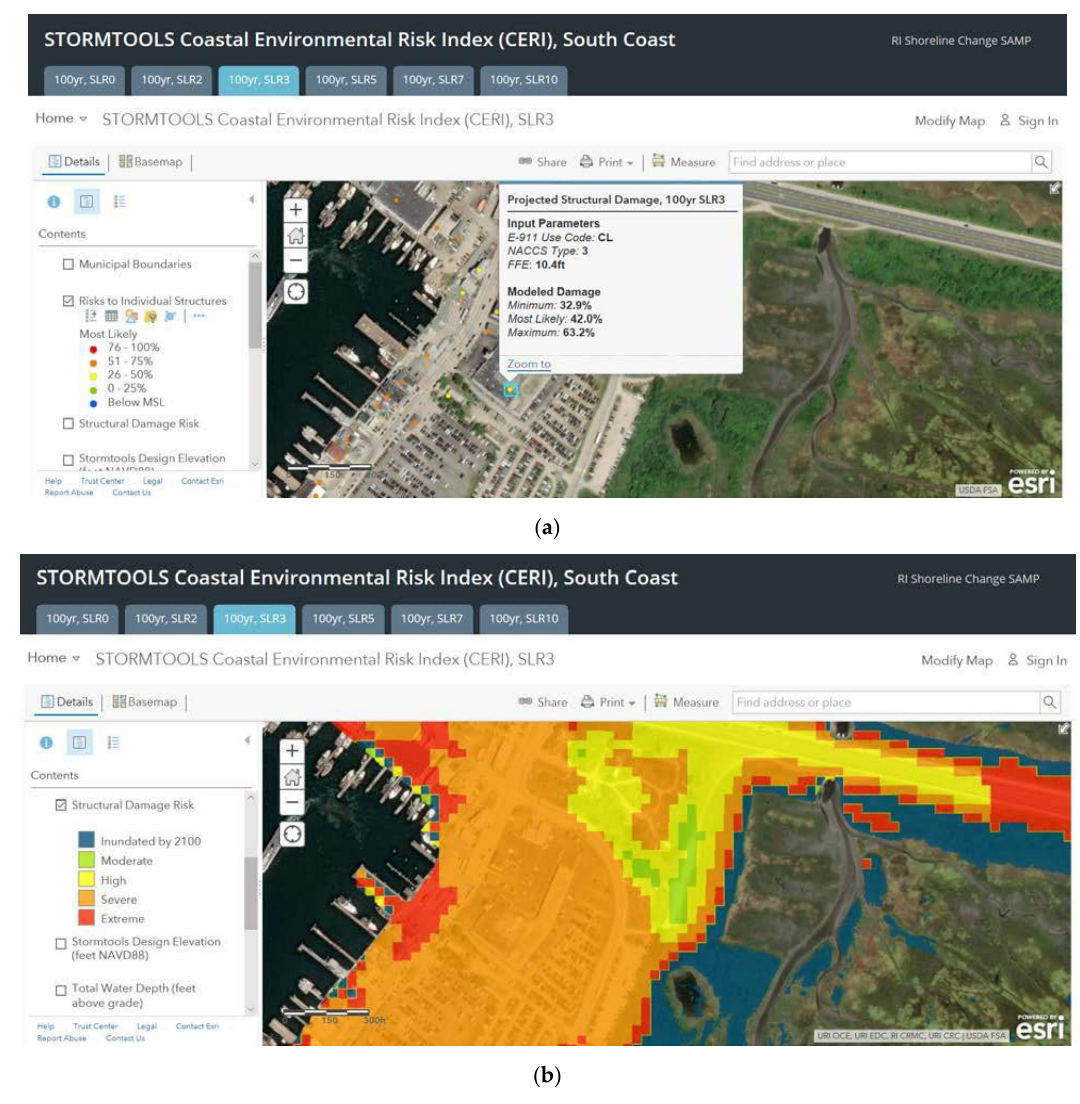
Figure 15. CERI prediction of damage (minimum, most likely, and maximum) at a selected location in the Port of Galilee ( a ) upper panel for 100 yr, 3 ft SLR case. A description of the structure is provided followed by minimum, most likely, and maximum damage. A risk map for the same SLR case and the same area is shown in the ( b ) lower panel.